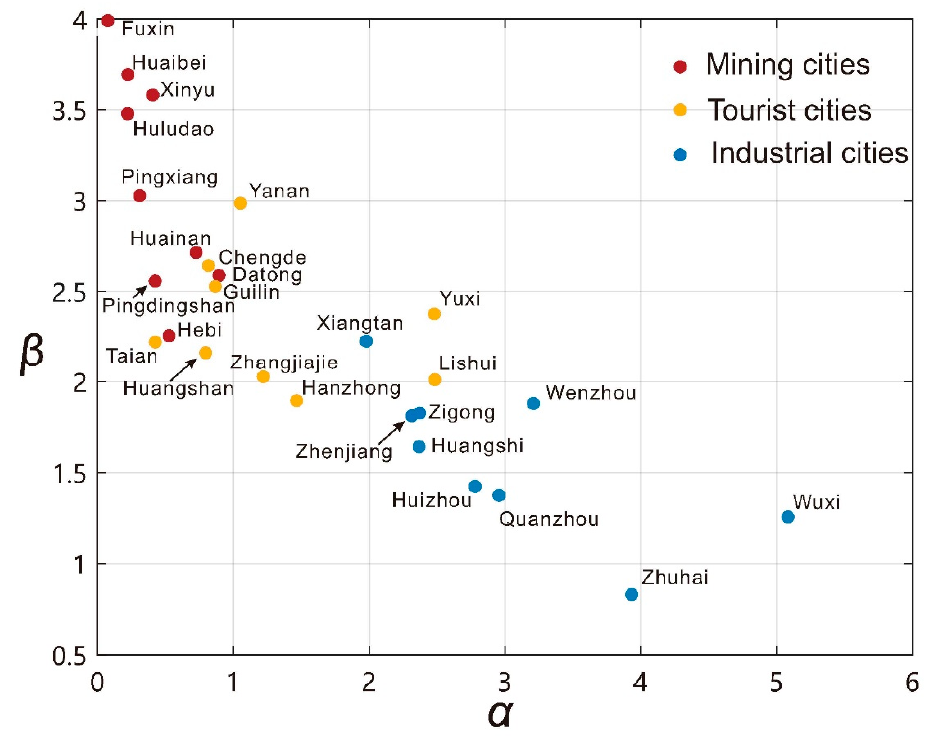
Figure 11. SSUDC coefficients for cities with different urban functional types.